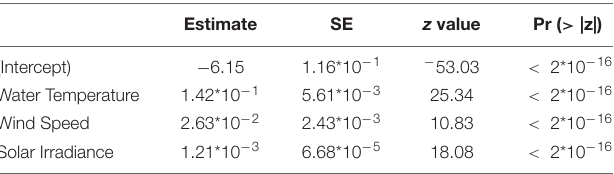
TABLE 2 | Results from the most representative GAM modeling for the presence/absence data of D. dentex, where metrics are also indicated: SE is the Standard Error of the estimated fitted mean parameter.